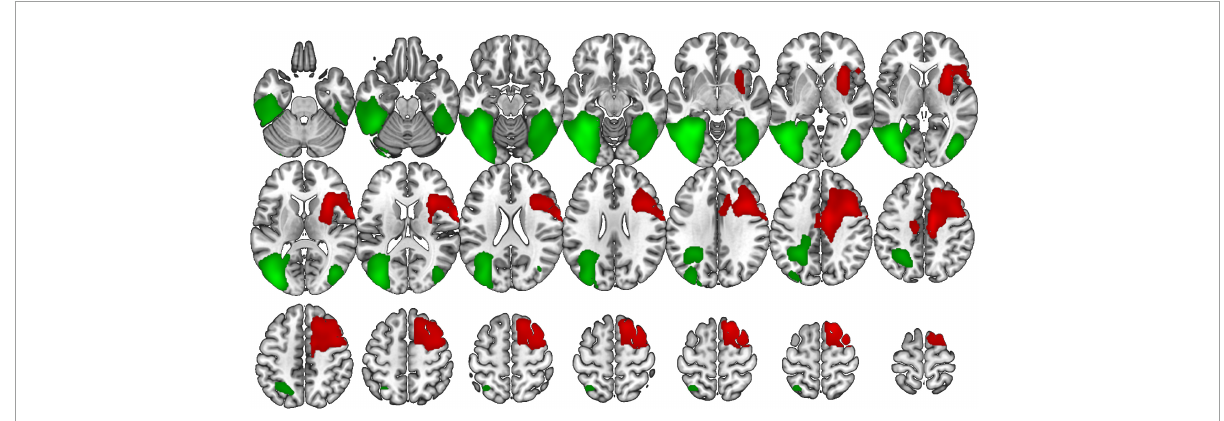
FIGURE3 Voxel-based brain mapping analysis showing the correlation between the VOSP-PD and brain metabolism in bvFTD (red) and AD (green) (FWE-cluster corrected p -value < 0.05). Images are shown in neurological orientation.